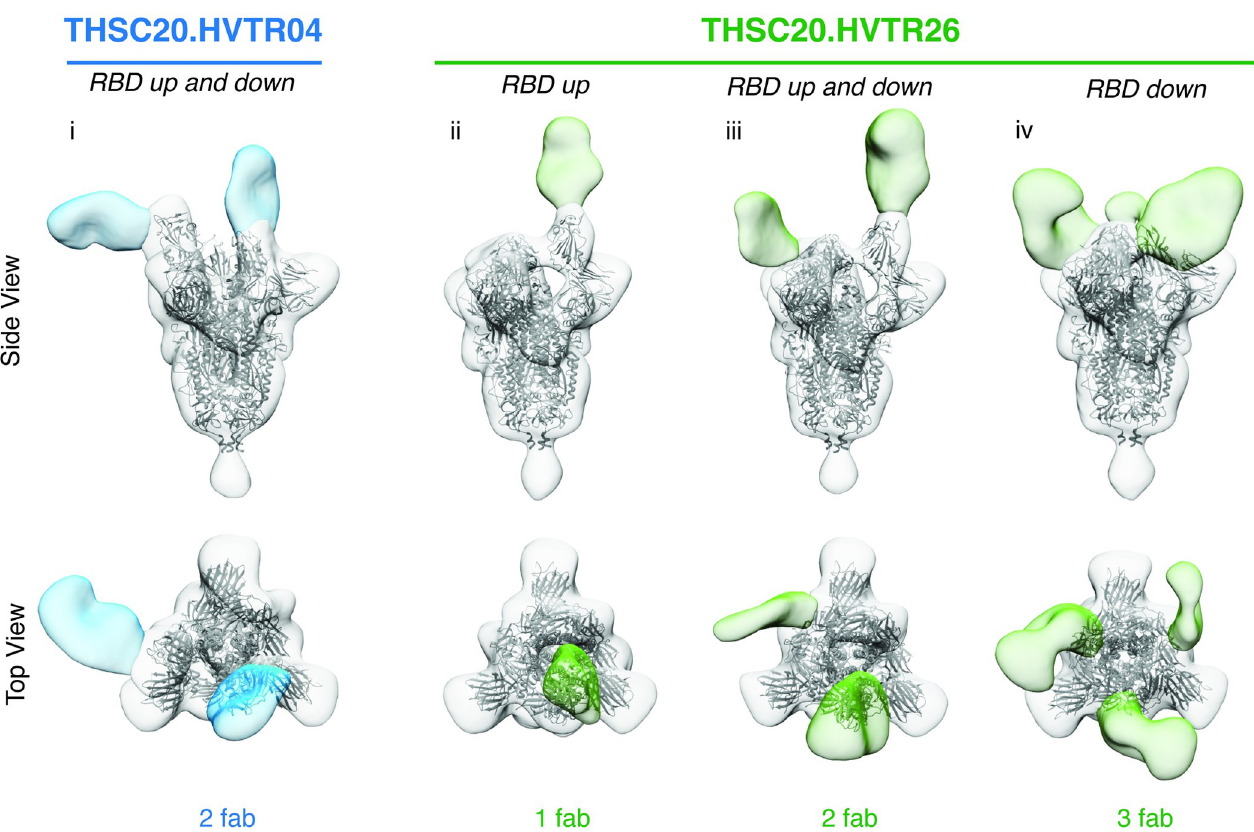
Fig 6. Negative stain EM analysis of mAbs complexed with SARS-CoV-2 spike protein. Negative stain EM analysis of mAbs THSC20.HVTR04 (blue) and THSC20.HVTR26 (green) complexed with SARS-CoV-2 6P Mut7 spike protein. PDB 6VYB (one RBD-up) was fit into maps i-iii, and PDB 6VXX (three RBD’s down) was fit into map